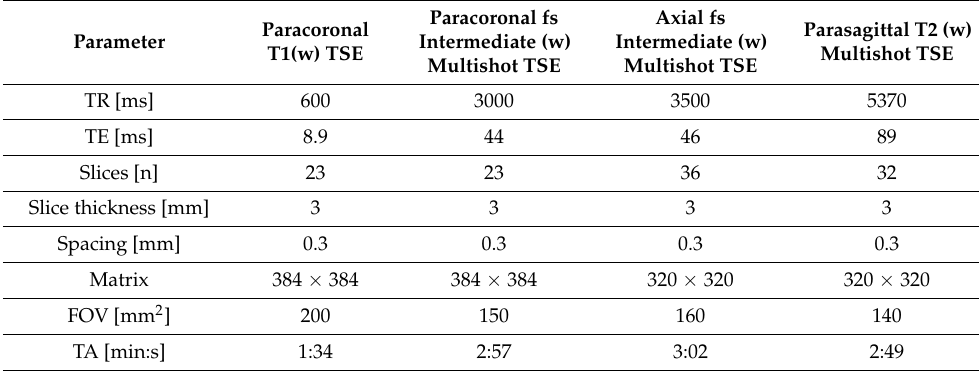
Table 1. Magnetic resonance imaging